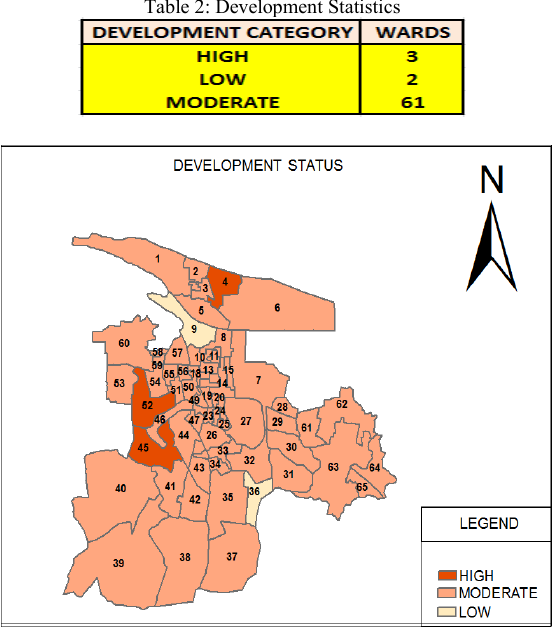
Figure 08: Map displaying the Development Status of